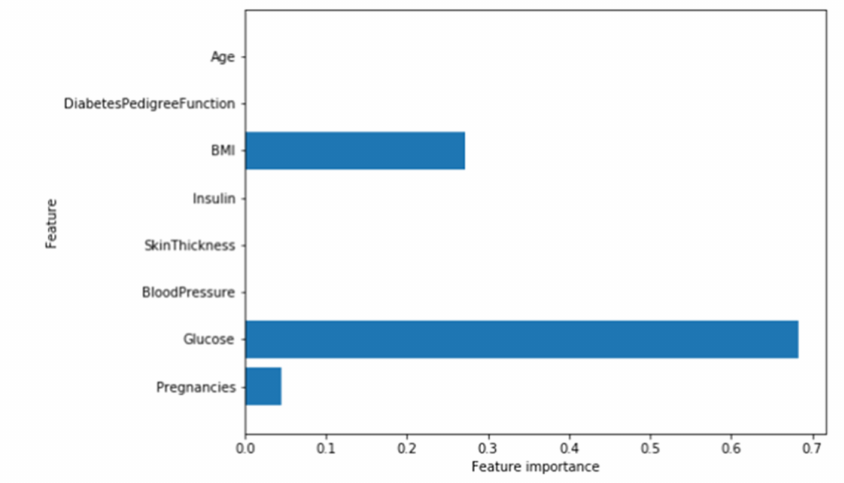
Figure 7. The most important extracted feature.